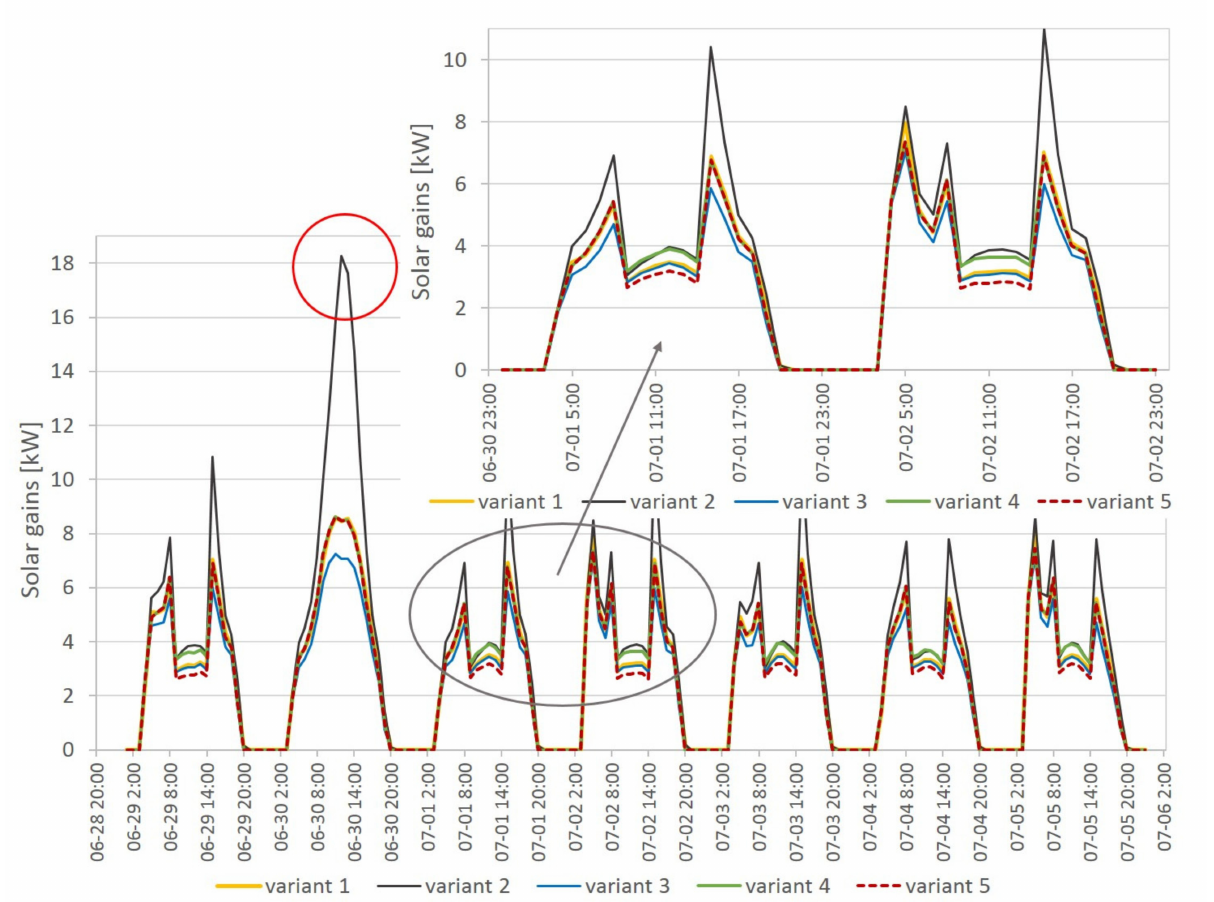
Figure 8. Solar gains output for the selected